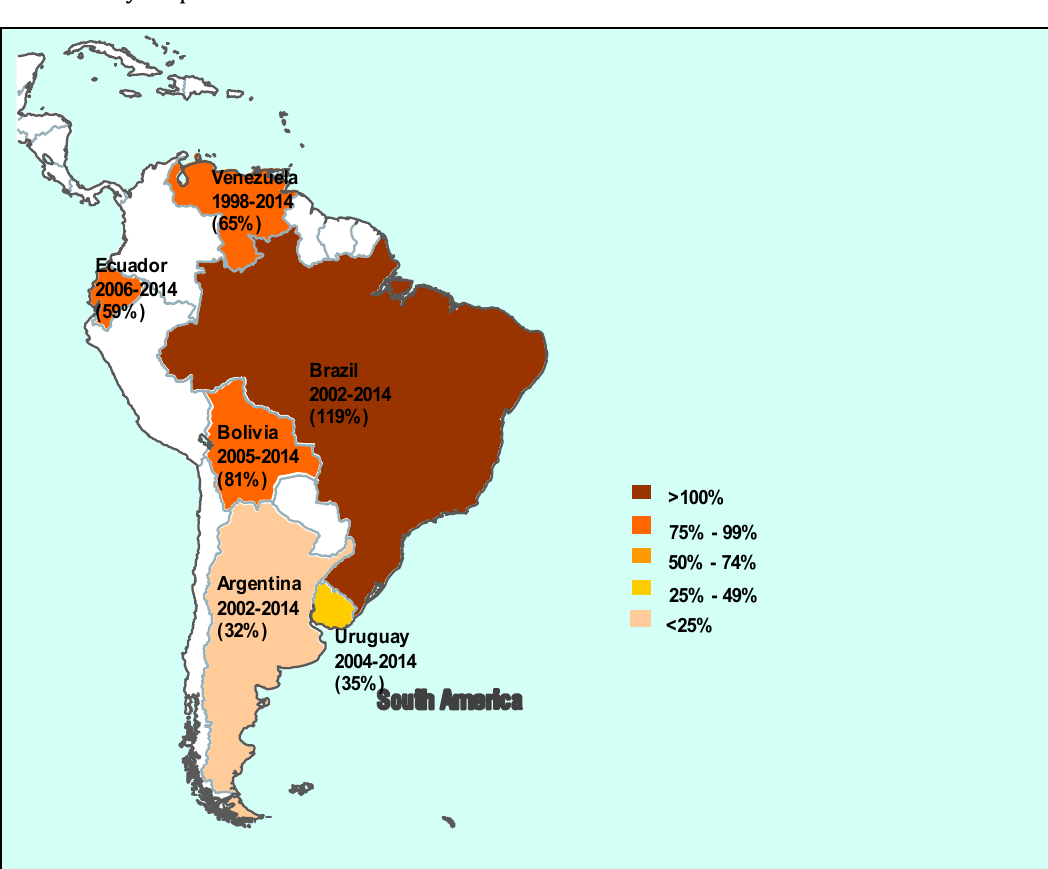
Figure 3: Growth rate of the incarceration rate in countries that have experienced political change, South